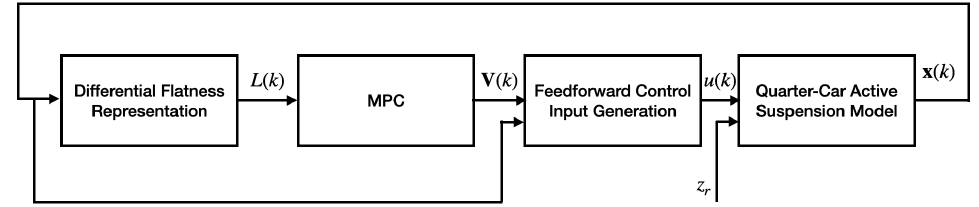
Figure 2. Block diagram of the proposed differential flatness-based Model Predictive